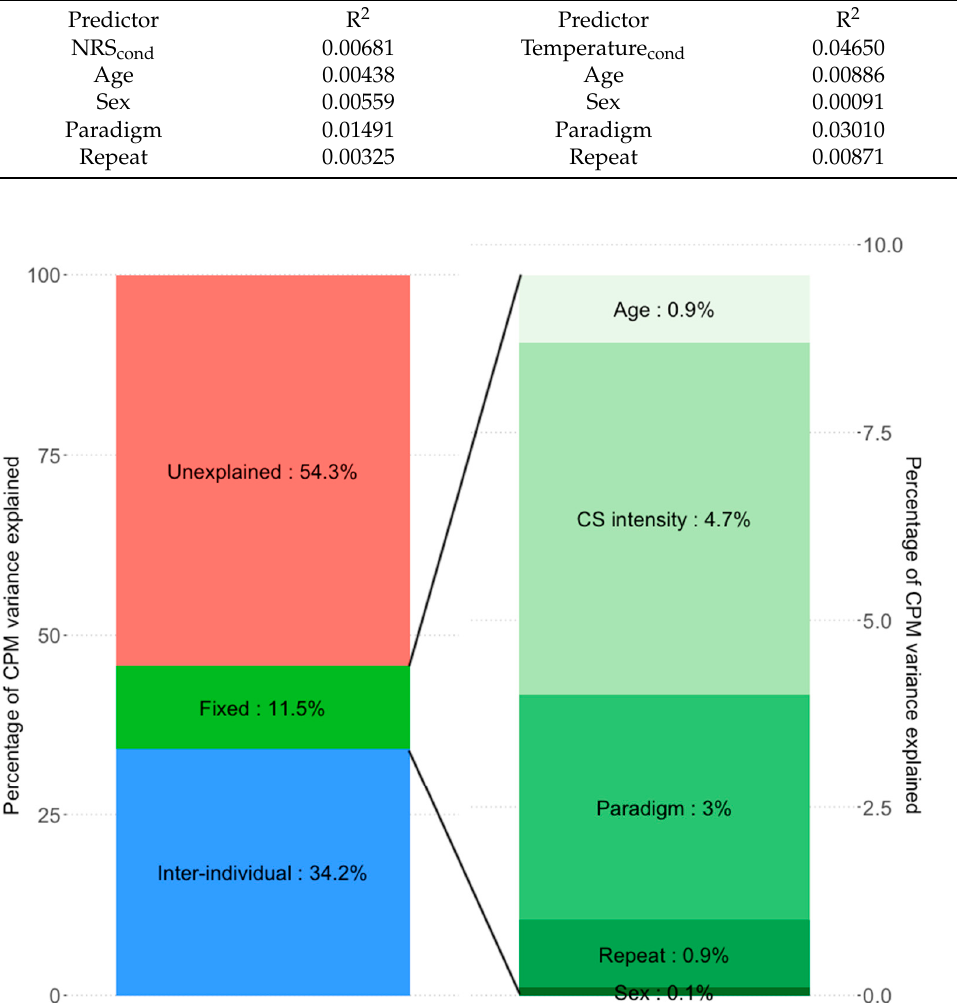
Models 5 and 6 does not sum to the variance explained by fixed effects in Models 3 and 4, respectively. This is due to the fact that the models used differ, resulting in slightly different fits. Additionally the statistical methods used for variance decomposition in the two types of analysis are different, which will further lead to discrepancies. Table 4. Variance in the CPM effect explained by fixed effects, including CS pain and physical intensity in the repeated measures analysis. Model 5: n = 85 participants, 184 observations; model 6: n = 52 participants, 118 observations, see Methods for model specifications. R 2 indicates the total variance explained by each individual predictor as calculated by the calc.relimp() (relaimpo package) in R. NRScond, pain intensity rating of conditioning stimulus on the NRS [0–10]. Temperaturecond, temperature of the conditioning stimulus (cold water bath). Paradigm, 30 s heat/60 s cold as opposed to Electrical/120 s cold (reference). Repeat refers to the measurement repeat and is used to control for order of measurement. Model 5 Model 6